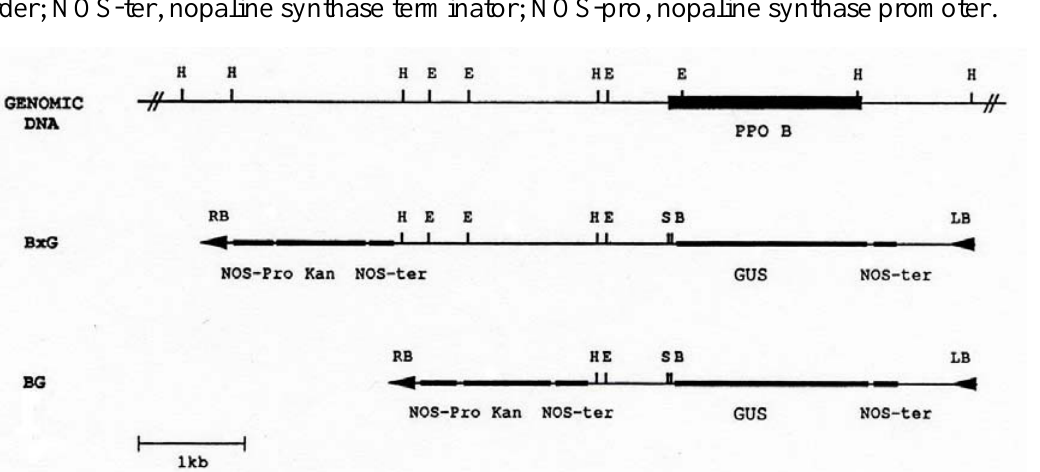
Figure 2. Restriction map of the PPO B promoter region and chimeric PPO B:GUS reporter constructions. The coding region of PPO B is indicated as a solid box. Construct BxG contained 2.52 kb PPO B 5' flanking DNA (bases -2520 to -1). Construct BG